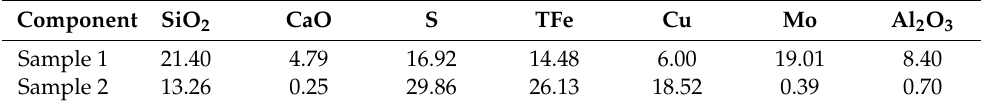
Table 1. Results of chemical multi-element analysis of